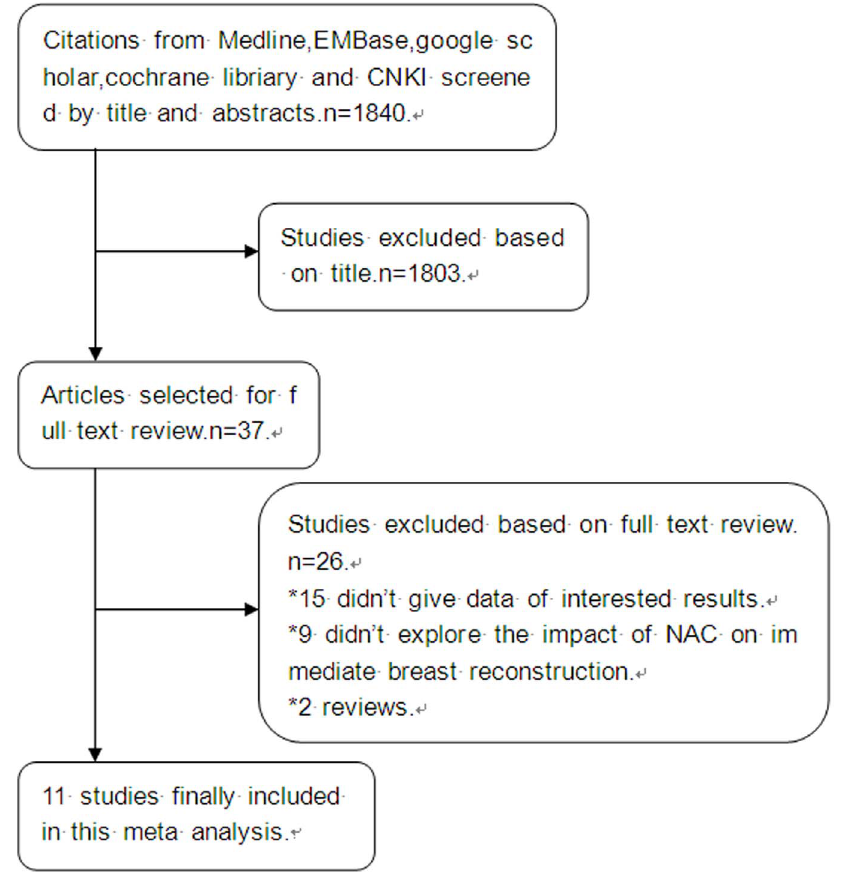
Figure 1. Flow chart of the study selection process.